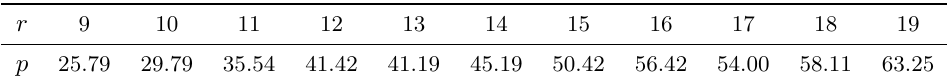
EDP instead of showing values 2